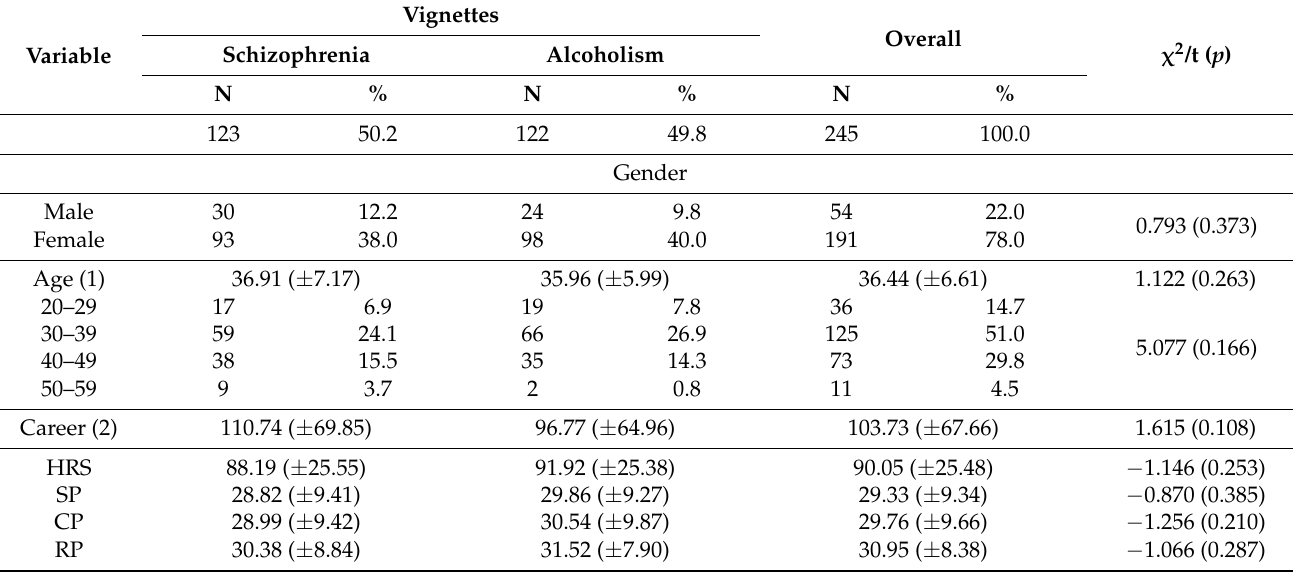
Table 1. Comparison of sociodemographic characteristics and HRS between